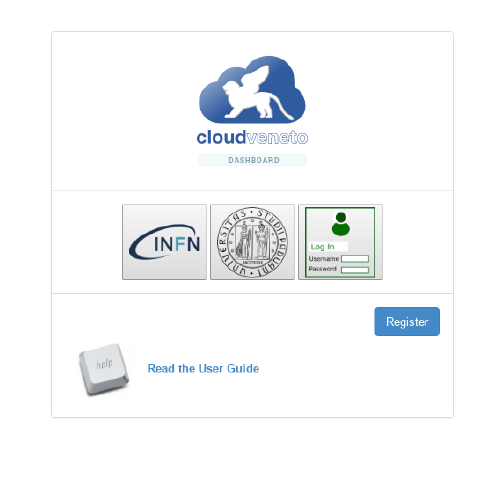
Figure 2. The CloudVeneto.it